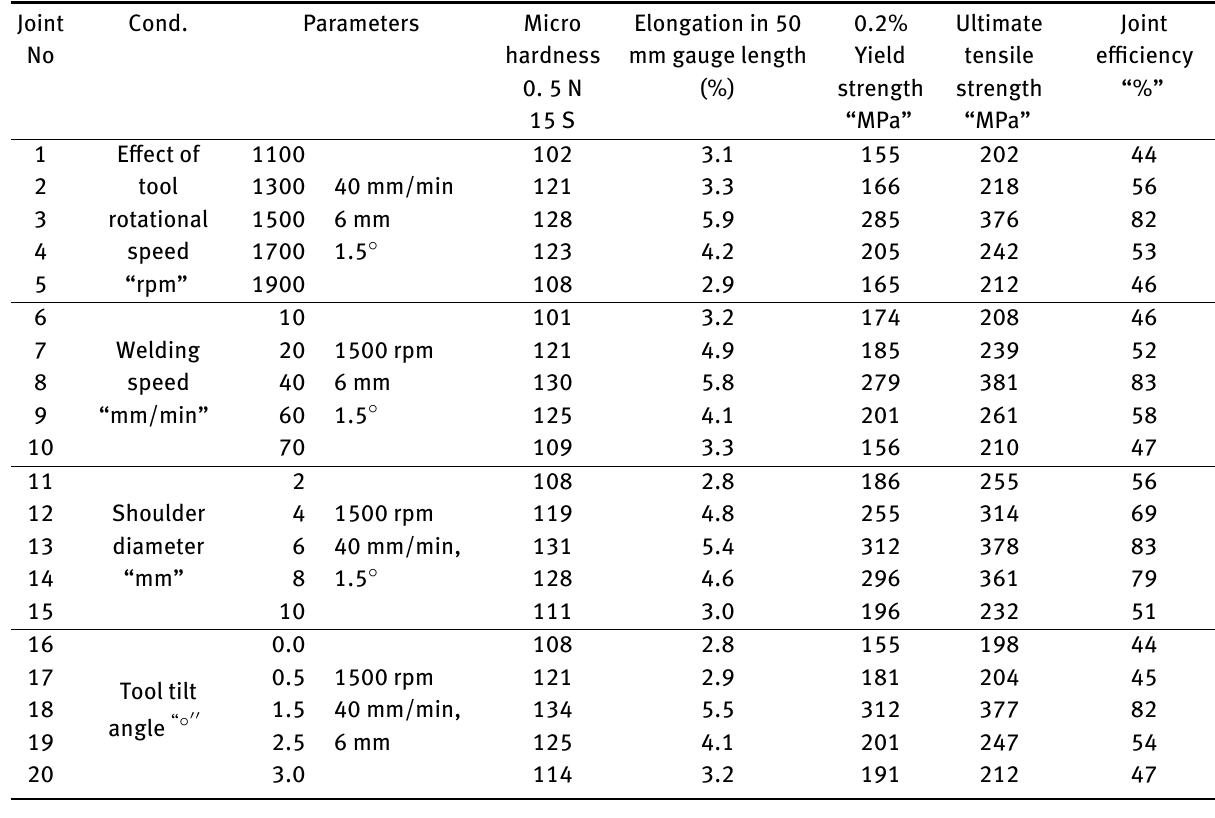
Table 4: Effect of FSW parameters on tensile strength Joint Cond. No